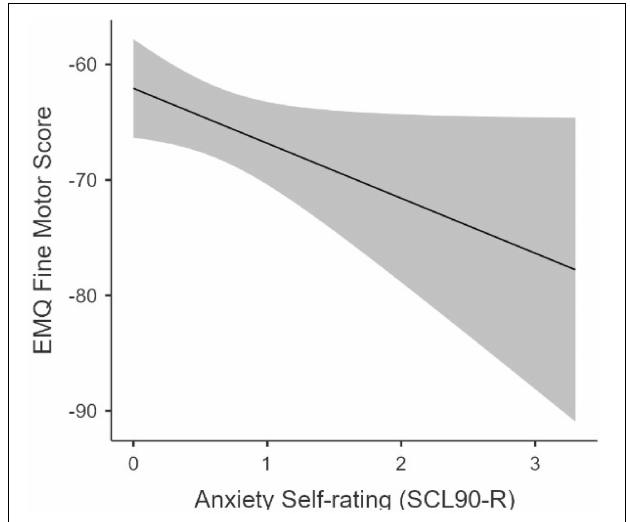
FIGURE 1 | Relation betweenMaternal Anxiety and Infant Fine Motor Scores. This figure demonstrates the relation between maternal anxiety self-ratings scores measured through the SCL90-R and infant fine motor scores at 3 months of ages as assessed on the parent-reported